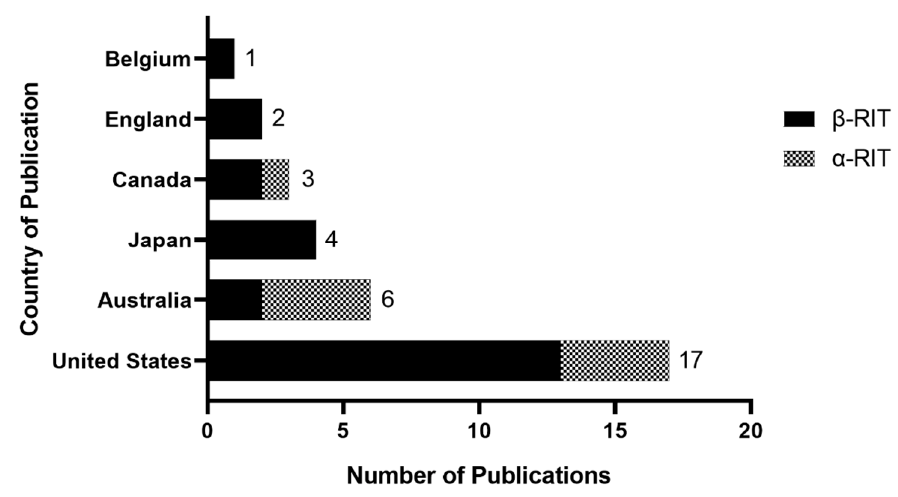
Figure 2. Distribution of publications of radioimmunotherapy (RIT) in pancreatic ductal adenocarcinoma (PDAC) by country of origin.